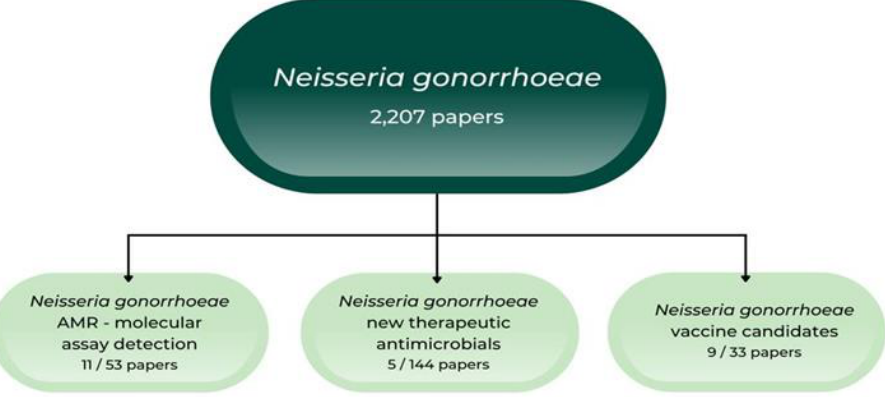
Figure 1. Diagram of analyzed studies.